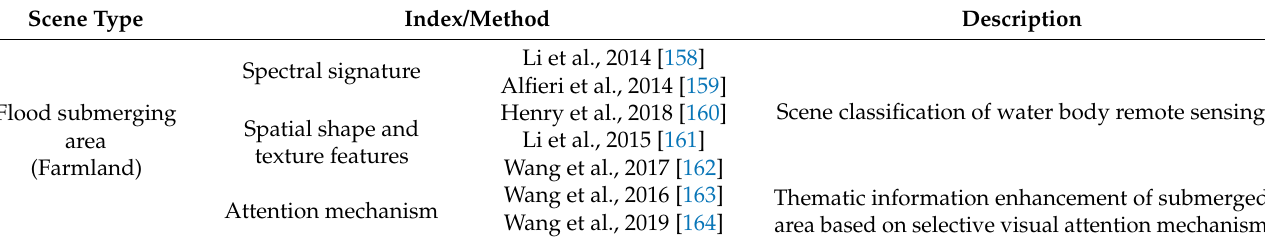
Table 11. Scene classification approaches for disaster-bearing